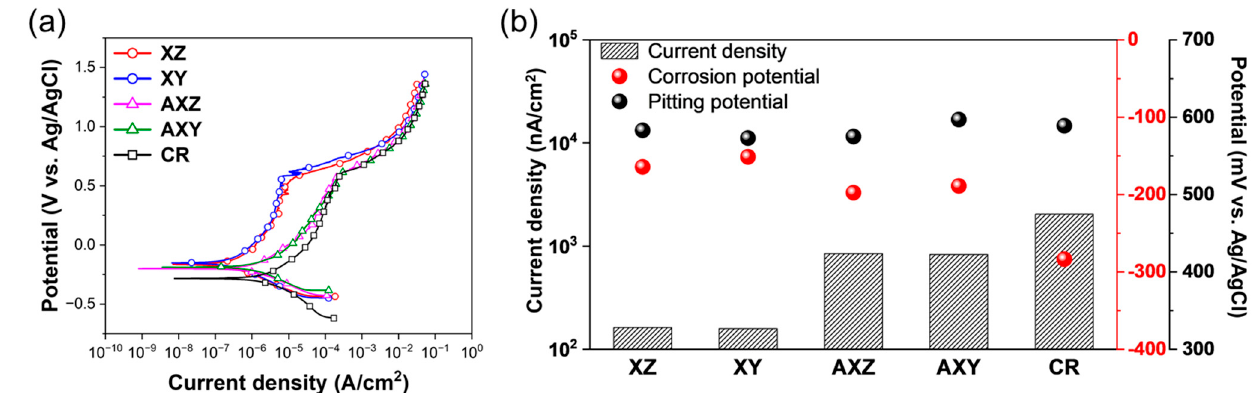
Figure 3. Corrosion resistance of each specimen in 3.5 wt.% NaCl. ( a ) Potentiodynamic polarization curves. ( b ) Comparison of corrosion and pitting potential, and current density.